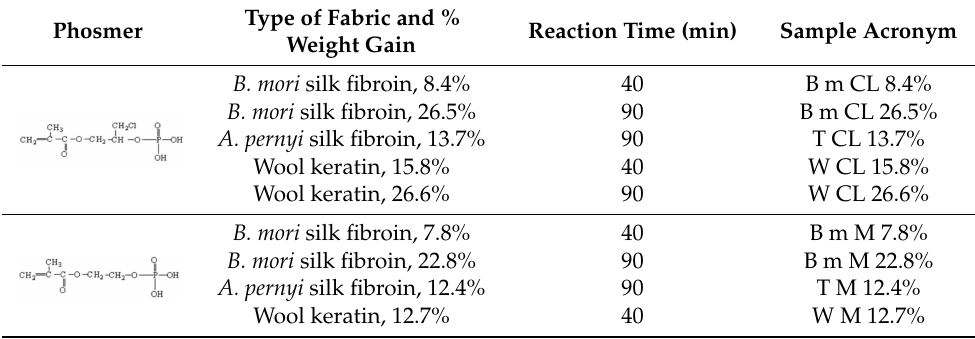
Table 1. Grafted samples analyzed in the present study via vibrational spectroscopy. Weight gains are indicated together with reaction